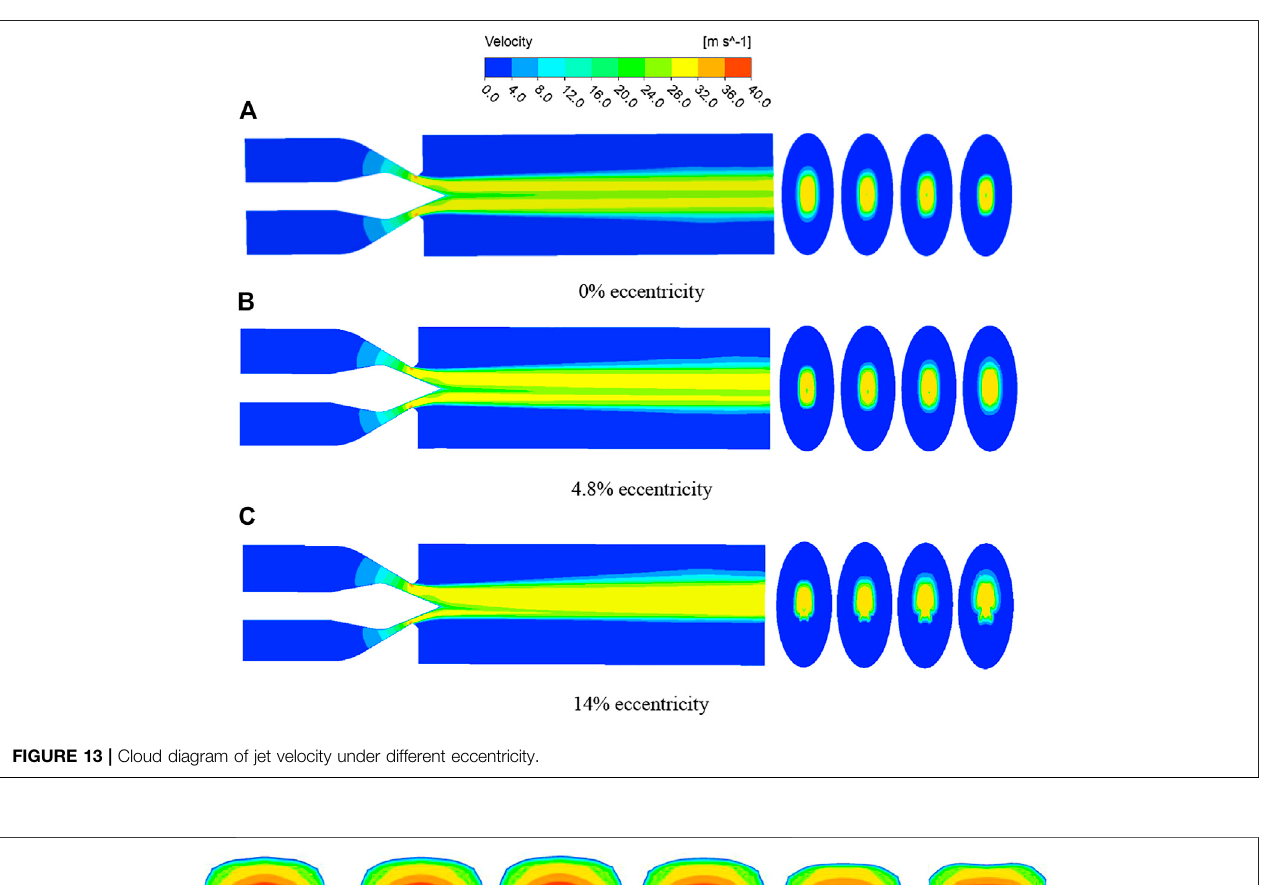
FIGURE 13 | Cloud diagram of jet velocity under different eccentricity.